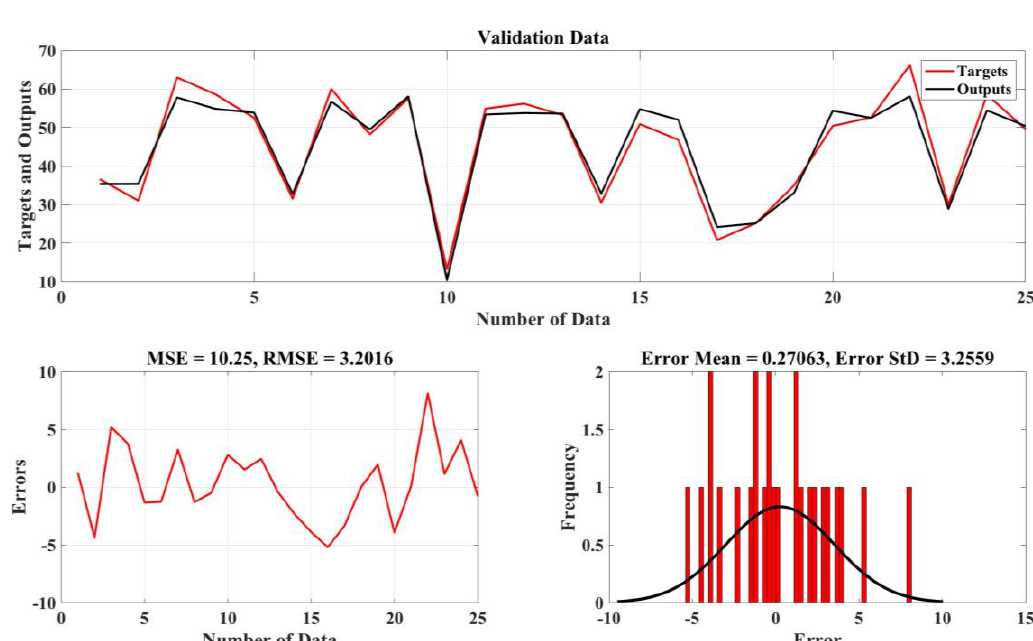
Fig.2. Results of the train data.